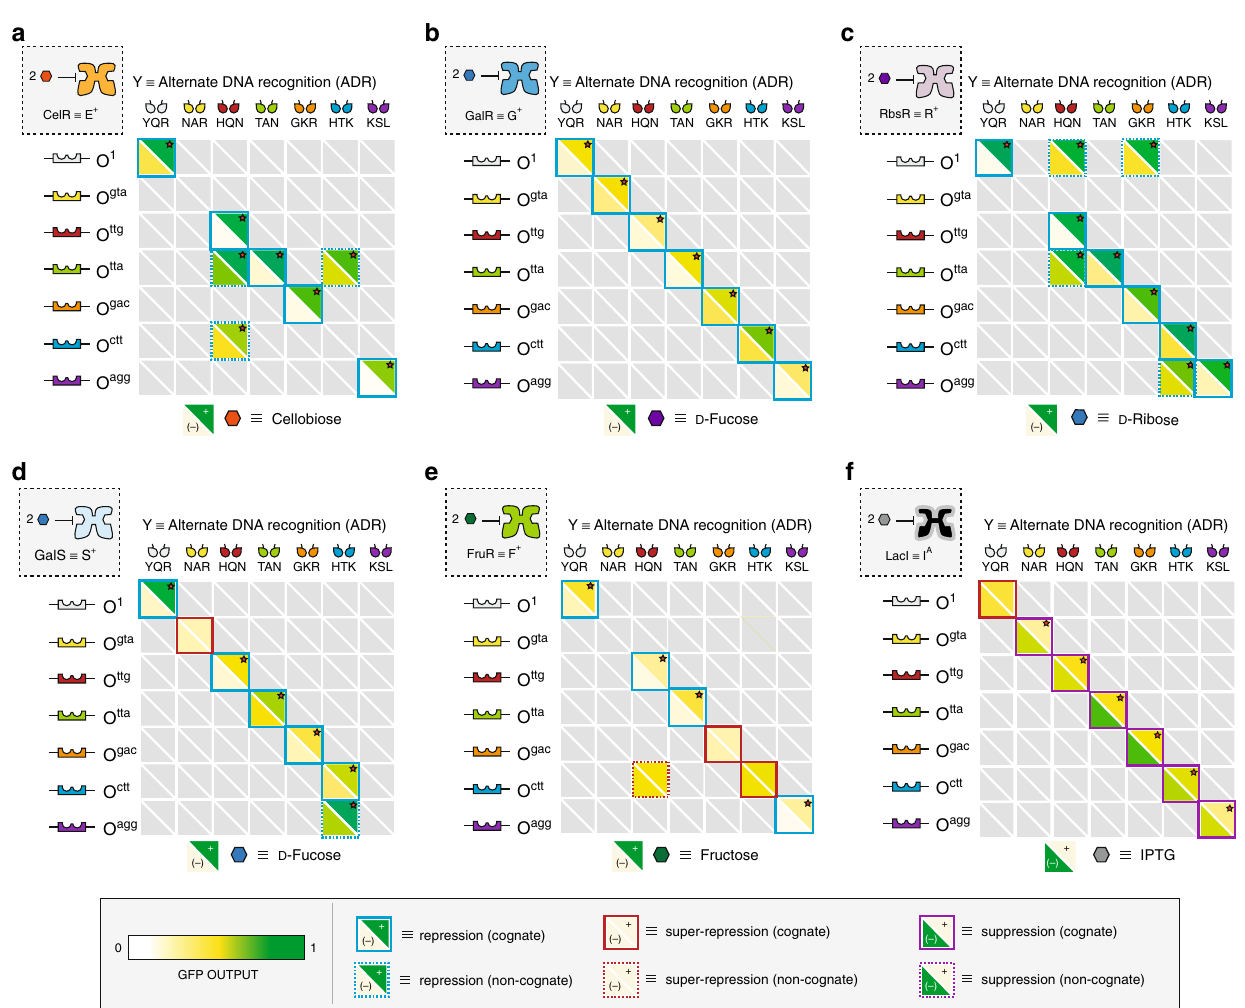
Fig. 2 Repression matrices for the regulatory core domains equipped with ADR units. a Cellobiose Repressor, CelR ≡ E, b Galactose Repressor, GalR ≡ G, c Ribose Repressor, RbsR ≡ R, d Galactose Isorepressor, GalS ≡ S, e Fructose Repressor, FruR ≡ F and f a representative antilac I A(1) . The ADR DNA- binding domains are displayed along the top of the table and their corresponding operators are shown along the left. The bottom left triangle shows (OD 600 normalized) GFP output in the absence of inducer, while the top right shows GFP output in the presence of 10 mM of the inducer corresponding to a given RCD. Red stars denote a statistically signi fi cant difference between the two states at α = 0.001 level using a one-tailed Student ’ s t -test. Values correspond to the mean of n = 12 biological replicates. Scale bar reference for GFP output are all scaled to the same absolute values (inset, bottom). Phenotype is denoted by the color of bounding box in accordance with Fig. 1. TF-operator pairs along the diagonal are classi fi ed as interactions between the ADR and a cognate operator (solid boxes). Dashed boxes indicates promiscuity in DNA recognition. Any repressor-operator combination that was incapable of repression (X - phenotype) is denoted in